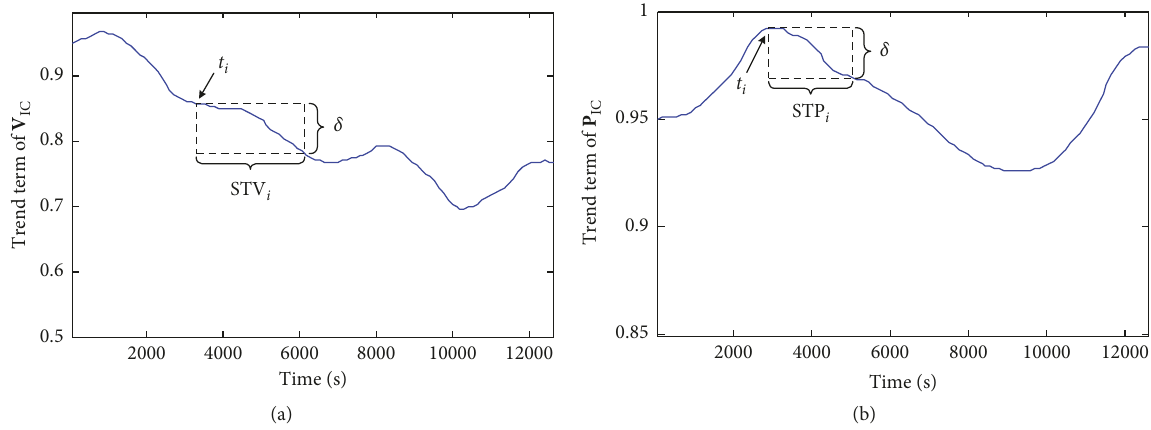
Figure 4: Illustration of ionospheric clutter nearly static time. (a) Nearly static time of V